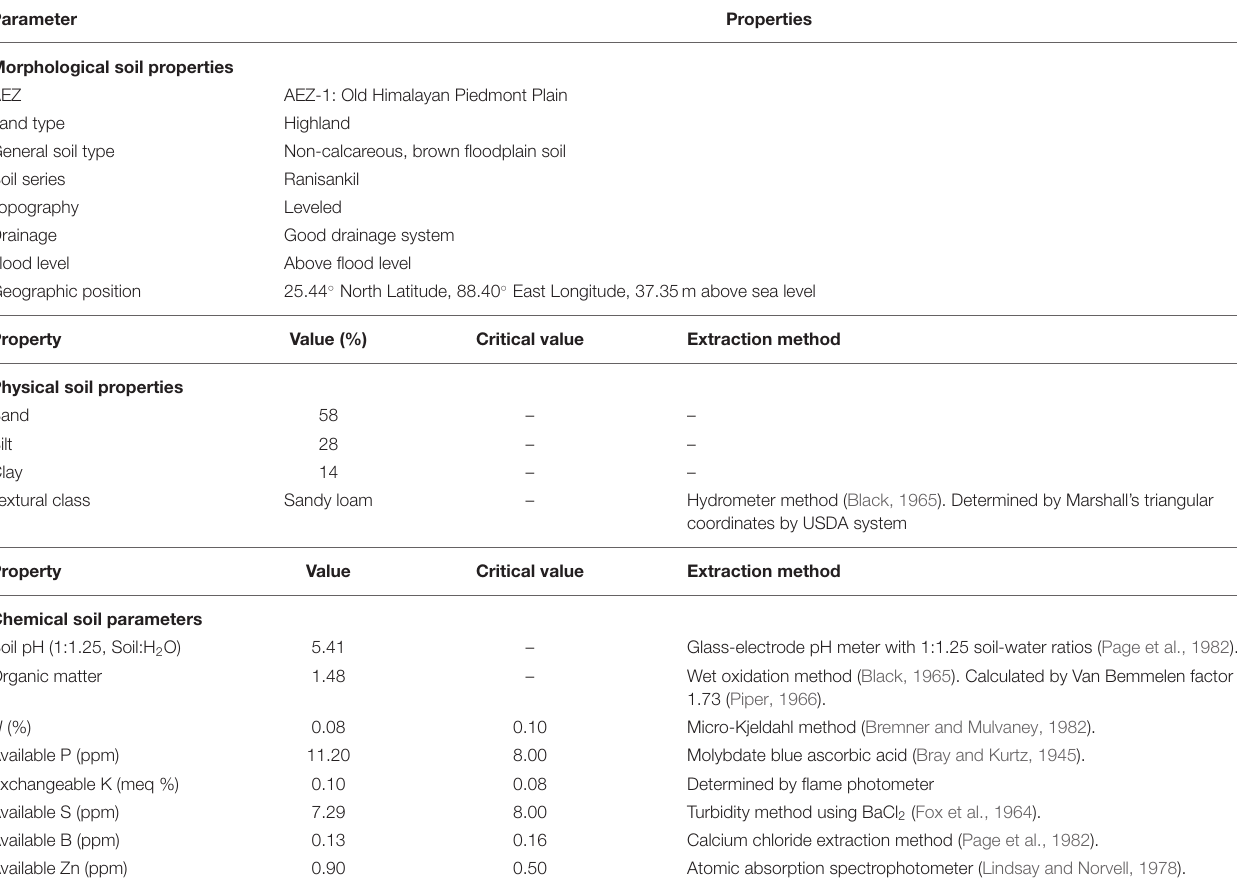
TABLE 1 | Morphology, physical and chemical properties of the soil of the research field, HSTU, Dinajpur, with the critical value and extraction method. Parameter